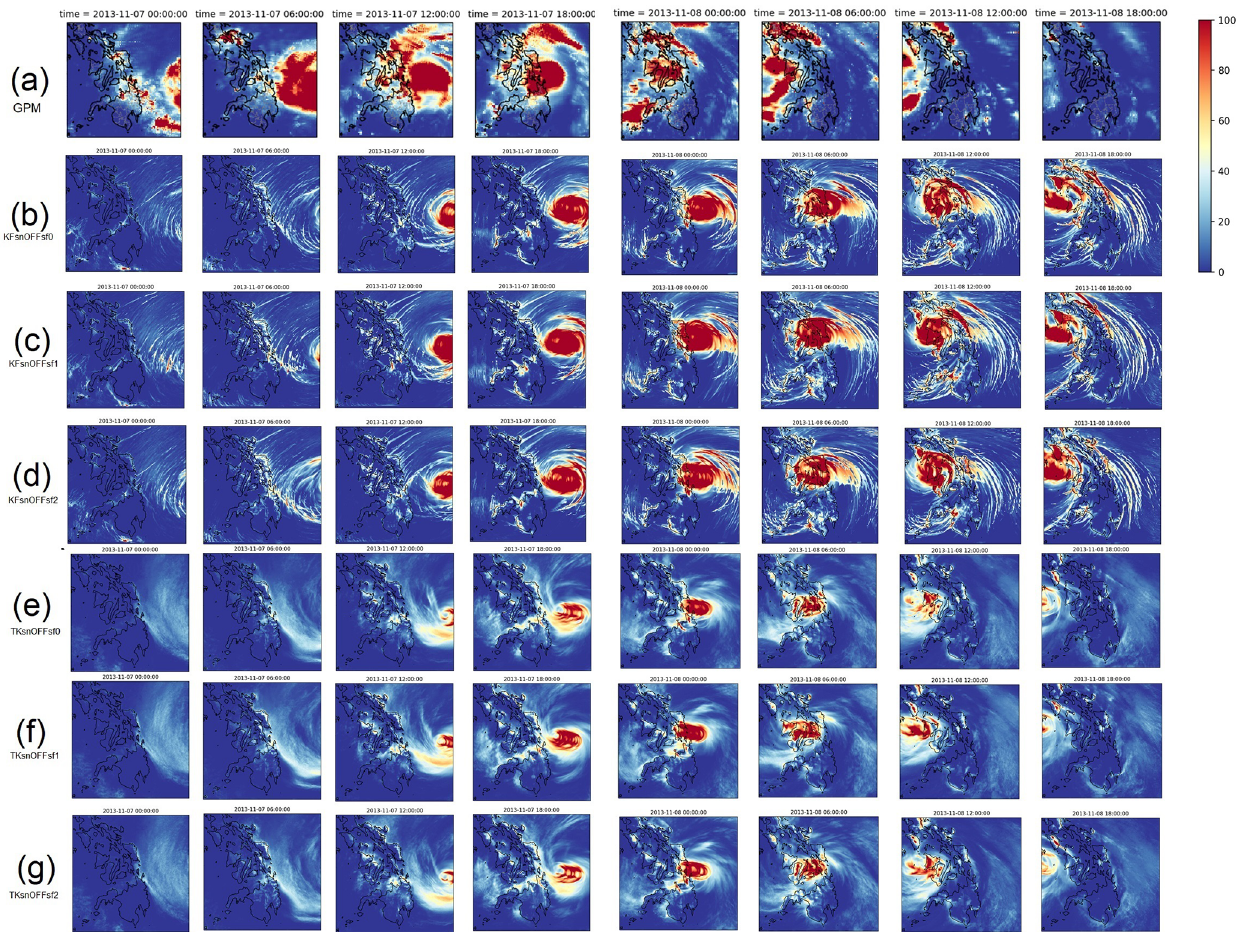
Figure 11. Spatial patterns of rainfall (in mm) every 6h from 00:00UTC on 7 November 2013 to 18:00UTC on 8 November 2013 for (a) GPM, and the different simulations without nudging using (b, c, d) KF with sf0, s1, and sf2, respectively, and (e, f, g) TK with sf0, sf1, and sf2,